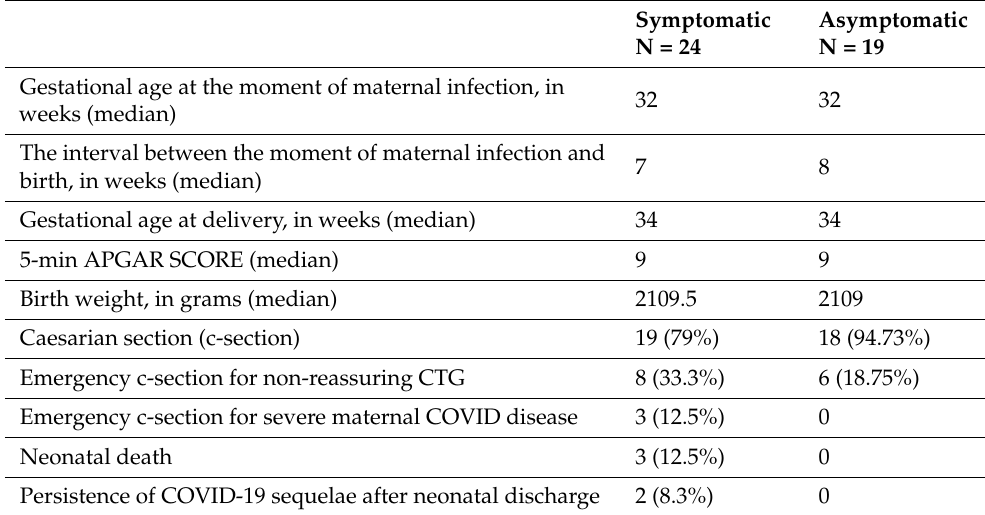
Table 2. Characteristics of livebirths.